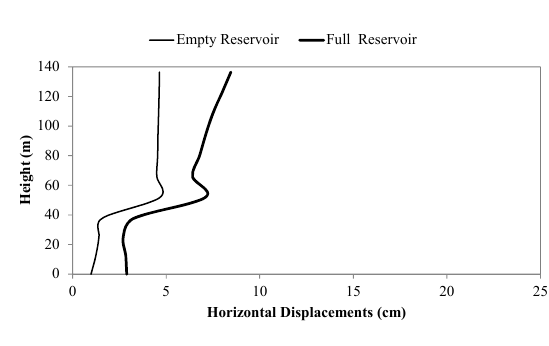
d) The maximum horizontal displacements in upstream direction according to non-linear analysis. Fig. 17. The maximum horizontal displacements in IV-IV section. Fig. 17. The maximum horizontal displacements in IV-IV